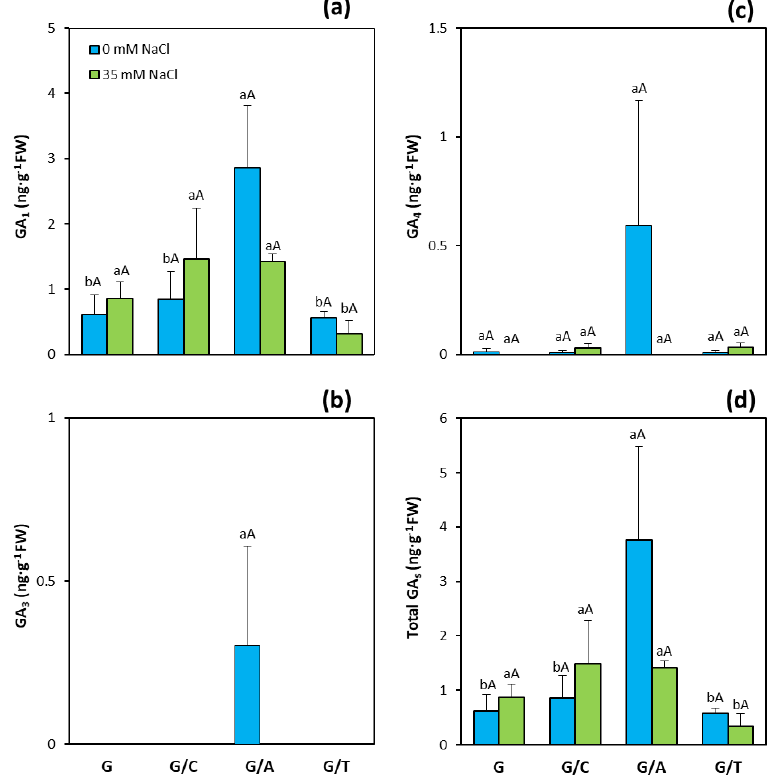
Figure 5. ( a ) Gibberellin A1 (GA 1 ), ( b ) gibberellin A3 (GA 3 ), ( c ) gibberellin A4 (GA 4 ), and ( d ) total gibberellin (GAs) concentrations in leaves of pepper plants of the commercial variety “Gacela F1” either non-grafted (G) or grafted onto the commercial rootstocks Creonte (G/C), Atlante (G/A), and Terrano (T/A), and cultivated under control (0 mM NaCl) and salinity (35 mM NaCl) conditions. Bars show the means of five plants ± standard error. Different capital letters indicate significant differences due to the salt treatment while different small letters show significant differences among graft combinations according to Tukey’s test ( p ≤ 0.05).